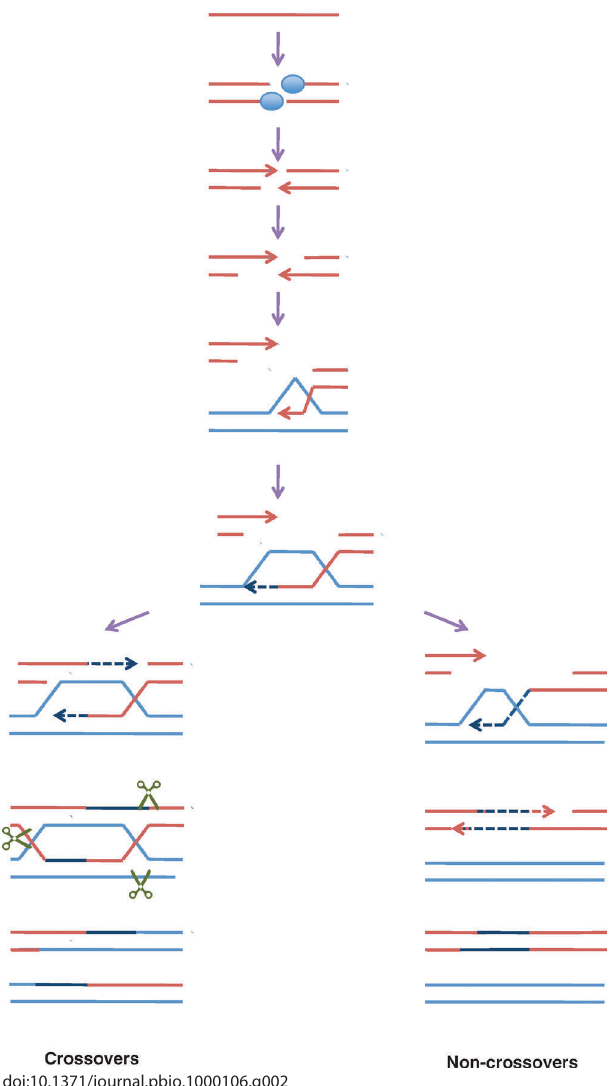
Figure 2. Recombination Is Initiated by Double-Strand Breaks Double-strand breaks are nonrandomly distributed at hotspots. Rcr1/ Dsbc1 influence the frequency with which particular hotspots are broken. Once broken, an exonuclease creates single-stranded DNA that can then invade the other parental chromosome. Just prior to, or at this time, other factors influence whether the crossover or noncrossover repair pathway is used. On the crossover pathway, the strand invasion primes DNA synthesis that displaces the resident strand. This is captured by the single-stranded DNA on the other side of the double-strand break, forming a structure called a Holliday junction. This is thought to be resolved by the recently discovered Gen1/Yen1 protein [36], illustrated by the scissors. This pathway results in the exchange of chromosome arms as illustrated in Figure 1. In the noncrossover pathway, strand invasion primes DNA synthesis forming a migrating D-loop. The unwound DNA pairs with the opposite side of the break, and more synthesis and ligation create a noncrossover recombination